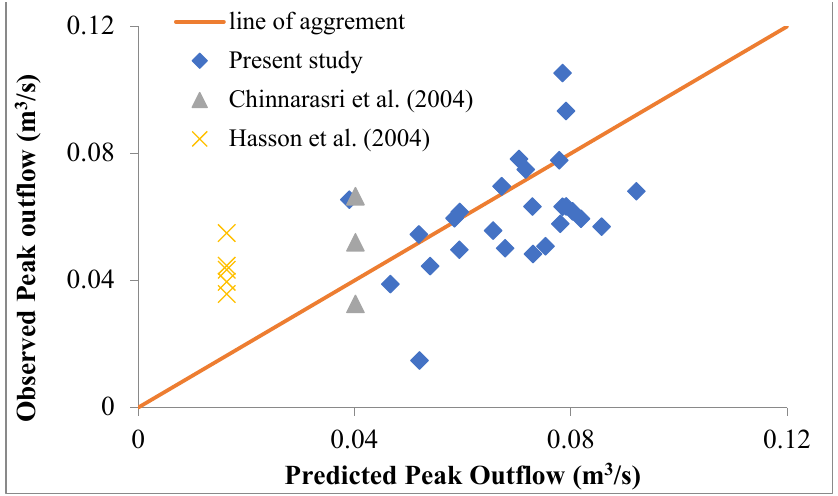
Figure 8. Variation of predicted and observed peak out fl ow using Equation (2) [26,30].